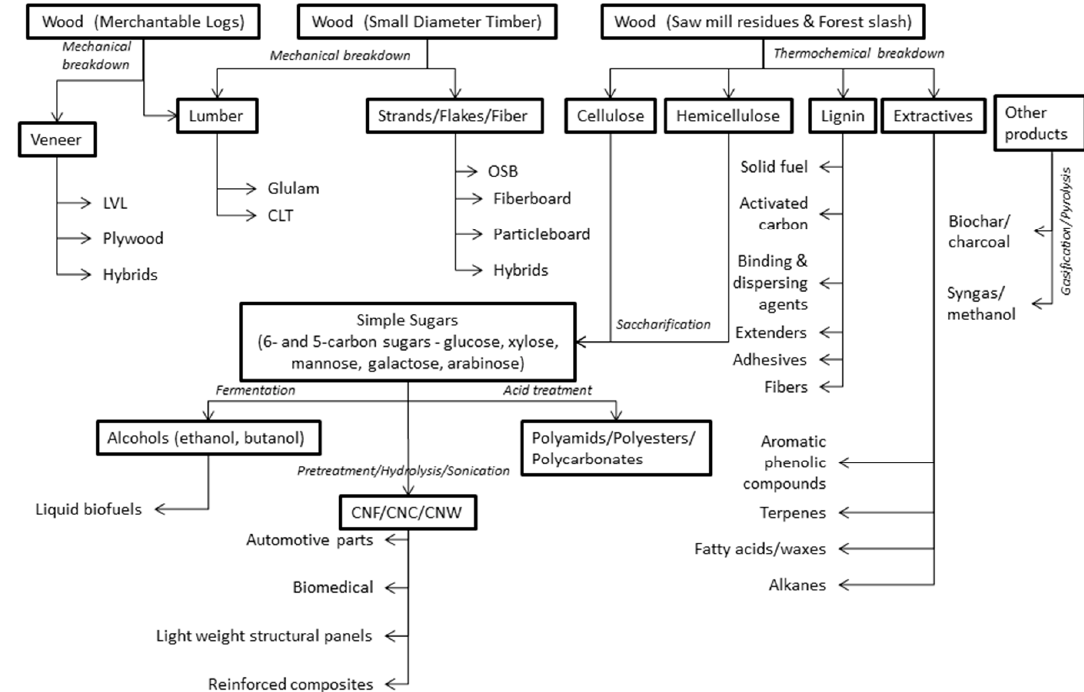
Figure 2. Raw material form, breakdown processes, and products that can be manufactured from small-diameter trees and woody biomass. Figure caption abbreviations to insert: (LVL=laminated veneer lumber, CLT=cross laminated timber, OSB=oriented strand board, CNF=cellulosic nanofibrils, CNC= cellulosic nanocrystals, CNW=cellulosic nanowhiskers) Source: Lowell et al. [44].